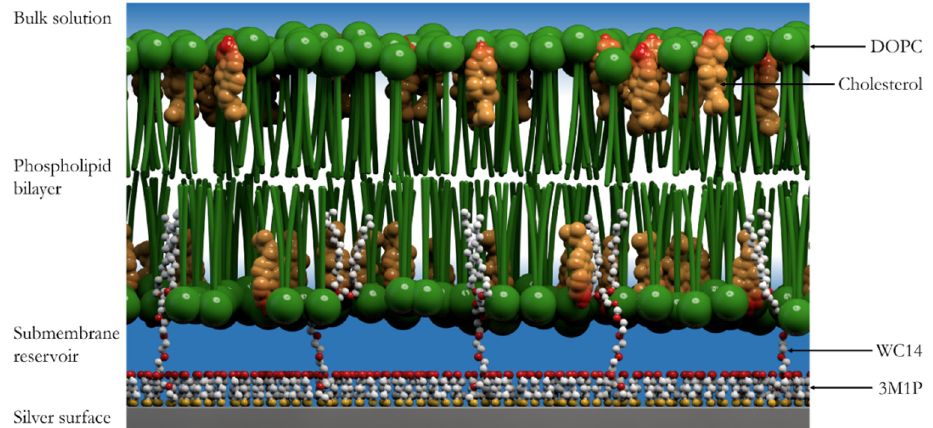
Figure 1. tBLM model on silver surface.